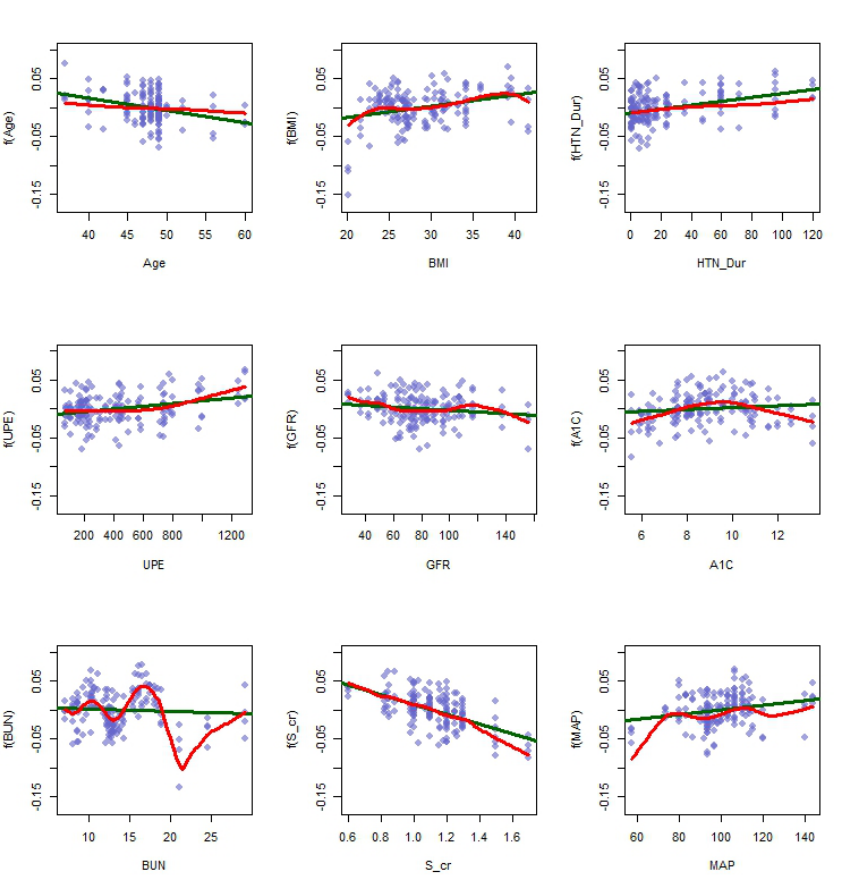
Figure 3. The red curves in the nine panels of this figure are the estimated effects f ( x ) , obtained by fitting Y = f ( x ) where x is Age, BMI, HTN _ Dur, daily UPE, GFR, A1C, BUN, S-cr , and MAP; the green lines in the panels are the linear fit of every